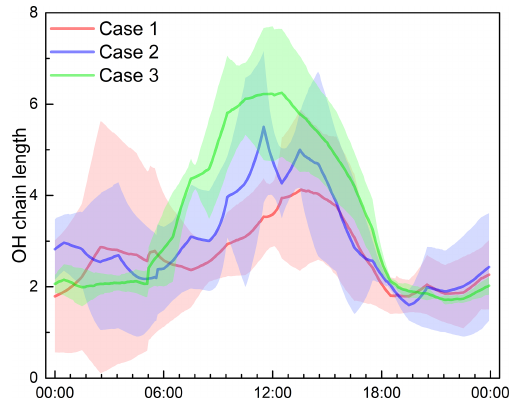
Figure 5. Average diurnal profiles of OH chain length during three cases at an urban site of Shanghai. The shaded area indicates the standard deviation of OH chain